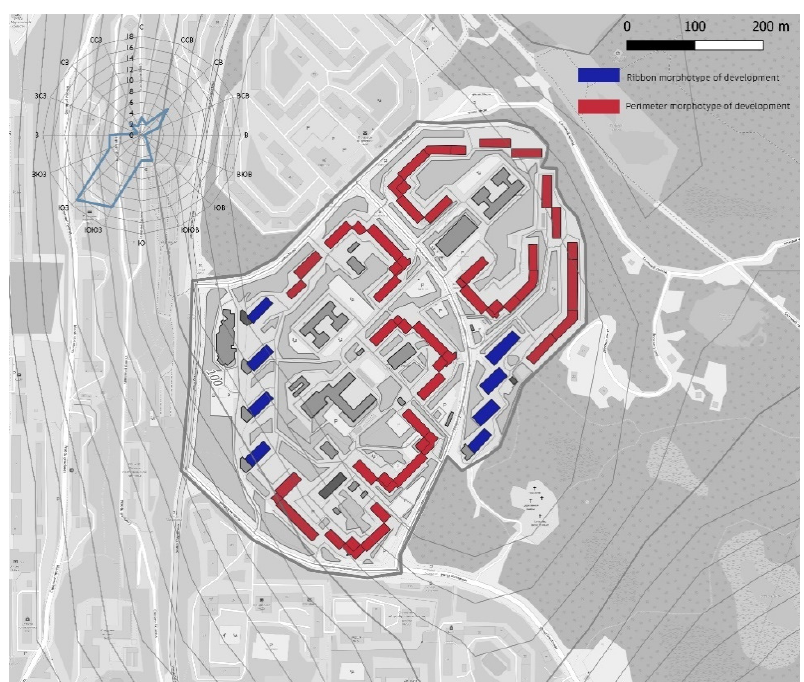
Figure 20. Site design developed for Neighborhood 403, Murmansk, that indicates the morphotypes of development and the prevailing wind direction. Table 6. Natural climatic characteristics of the winter period in Murmansk. Average Air Temperature of the Discomfortable